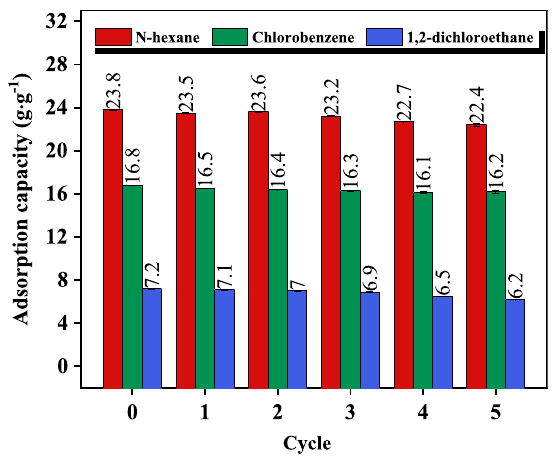
Fig. 11 OSs adsorption efficiency by BC/PU-5 foam composites for 5